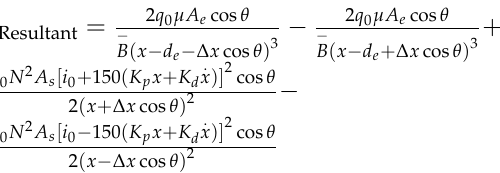
Figure 4. Relation curve between bearing capacity and displacement Δ x .